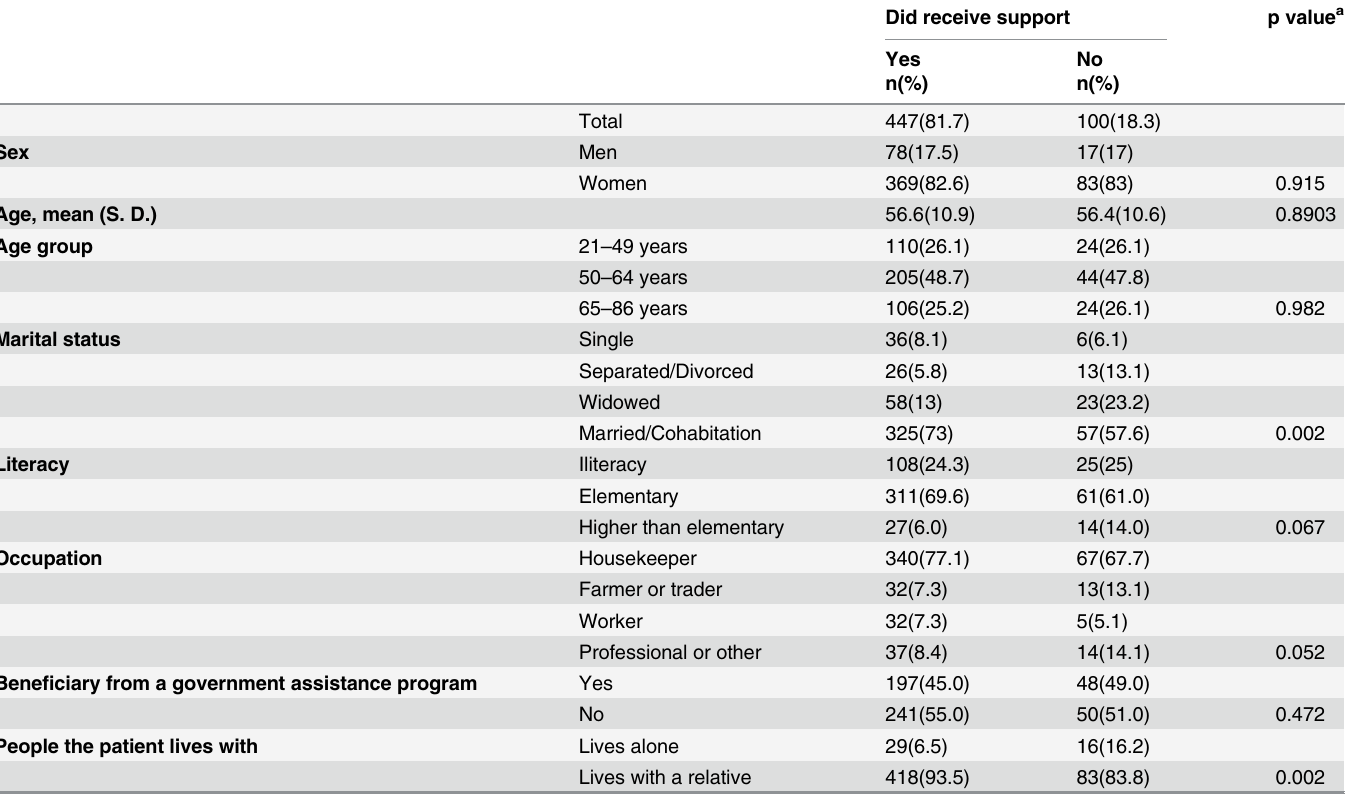
Table 2. Socioeconomic characteristics of surveyed patients according to “ receives support or not to care for the disease ”